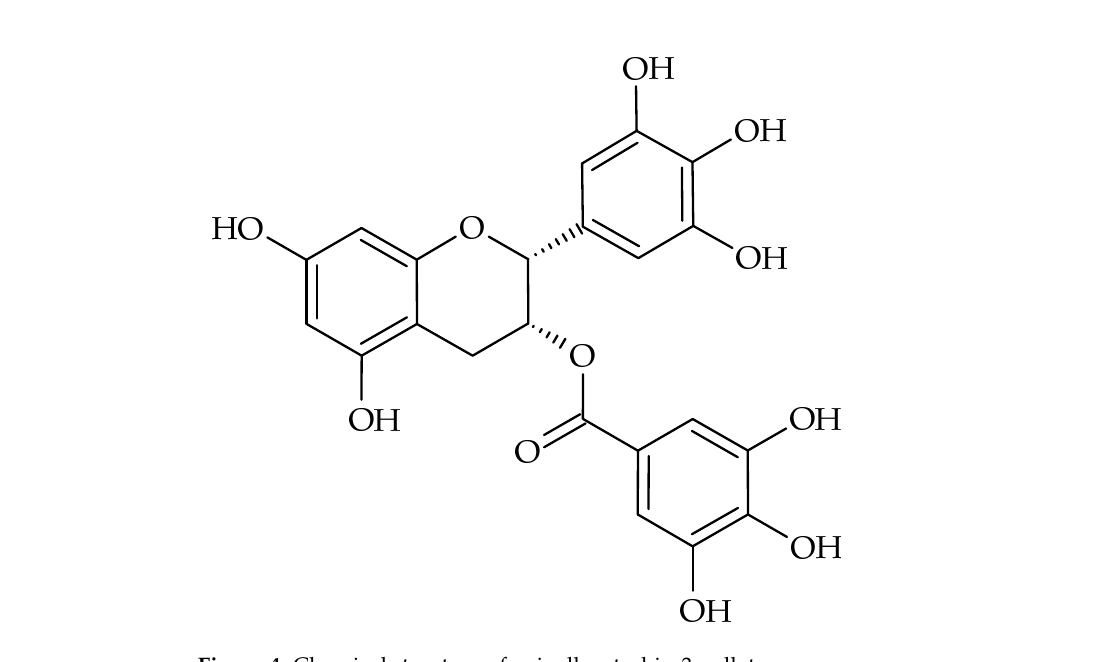
Figure 4. Chemical structure of epigallocatechin-3-gallate. Table 4. The efficacy of green tea polyphenols against oral